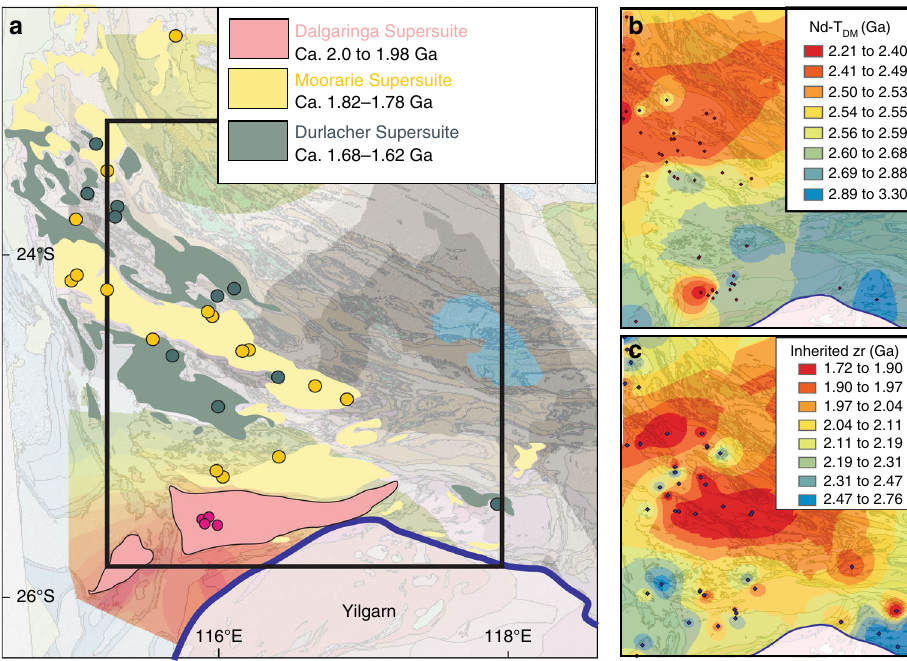
Fig. 4 Time slice comparison of MIF-S and conventional radiogenic isotope tracers as seen through the Proterozoic granitoid rock record. a Location of supersuites and samples analyzed for multiple sulfur isotopes. Transparent background of Fig. 3a, b. b Interpolated whole rock Nd depleted mantle model ages. c Interpolated average inherited U-Pb in zircon ages. Data 46 in b and c interpolated using an inverse distance weighted